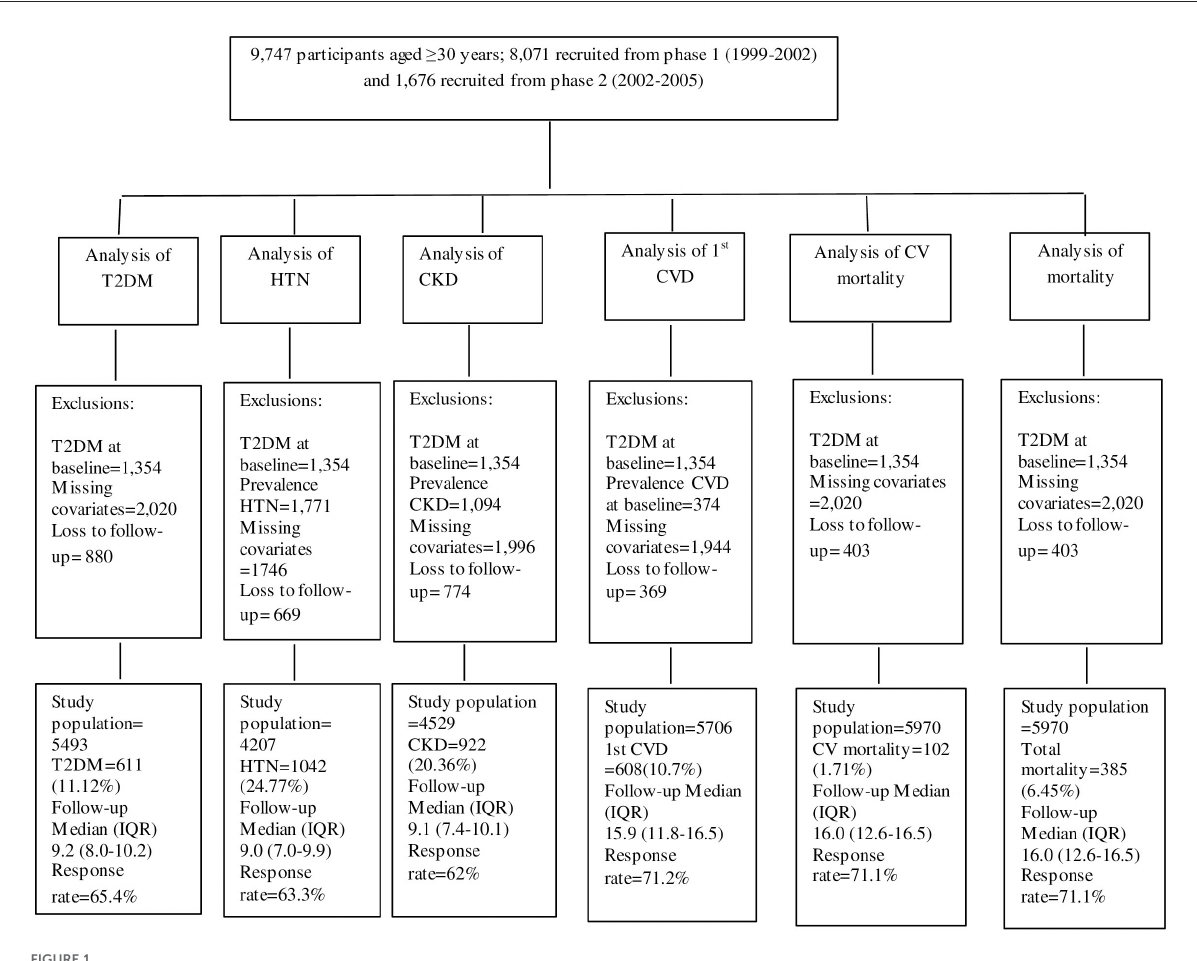
FIGURE1 Flow diagram of the study participants. TLGS, Tehran lipids and glucose